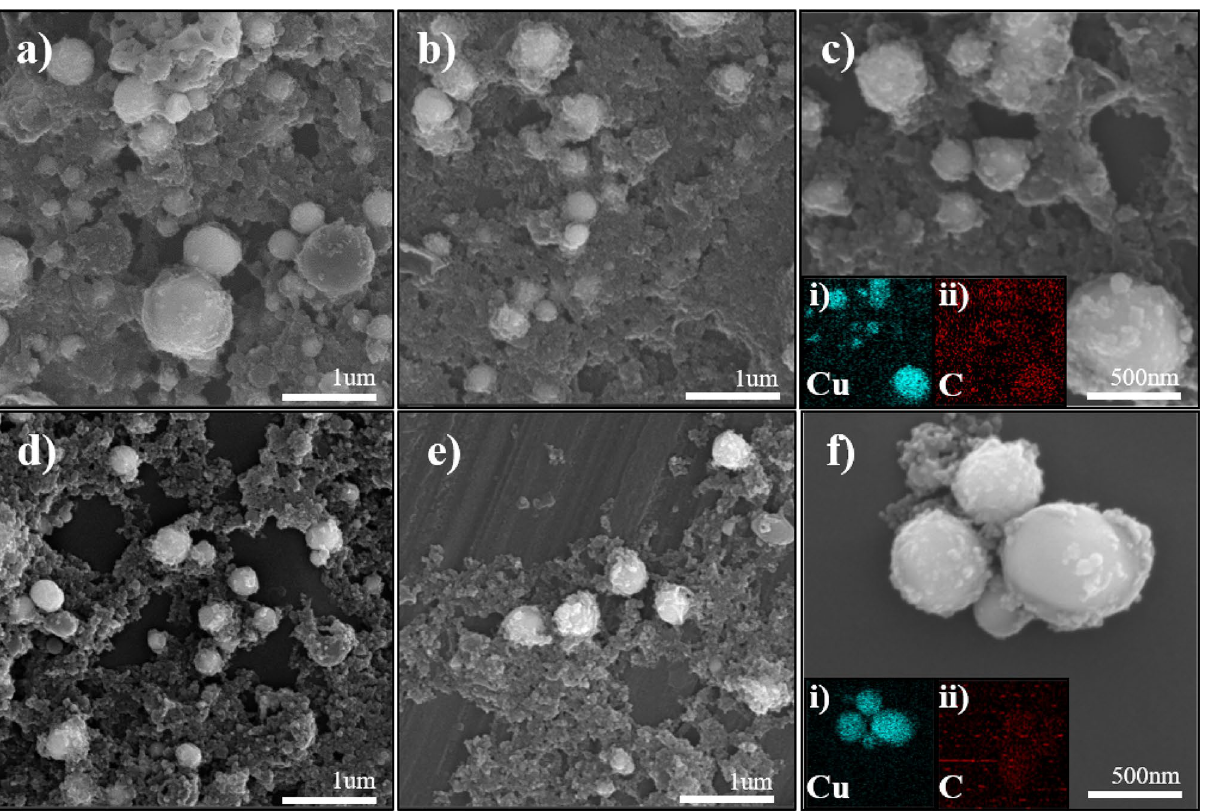
Figure 5. SEM images of samples synthesized in propionitrile at ( a ) 355, ( b ) 532, and ( c ) 1064 nm. ( c , i–ii) EDS analysis of the corresponding sample. SEM images of the material prepared in butyronitrile at ( d ) 355, ( e ),